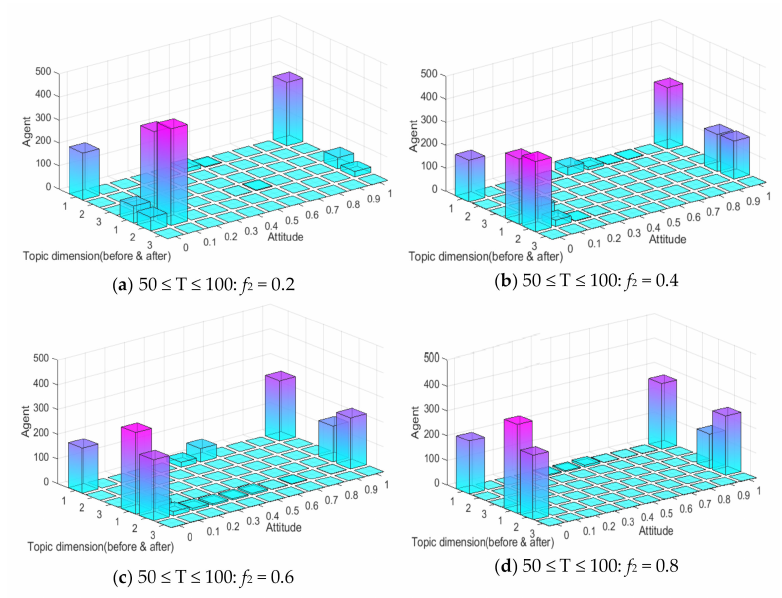
Figure 16. Histogram of group attitude distribution under different external information intensity at different moments.